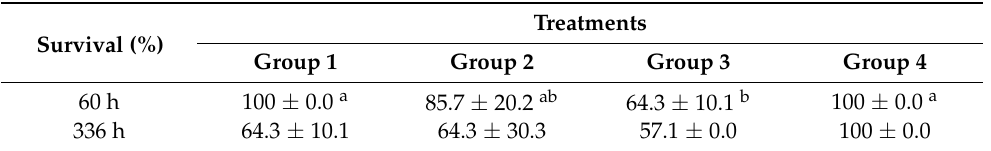
Table 4. The survival rates (%) of Pacific white leg shrimp at 60 and 336 h after Vc AHPND (16-904/1) immersion.